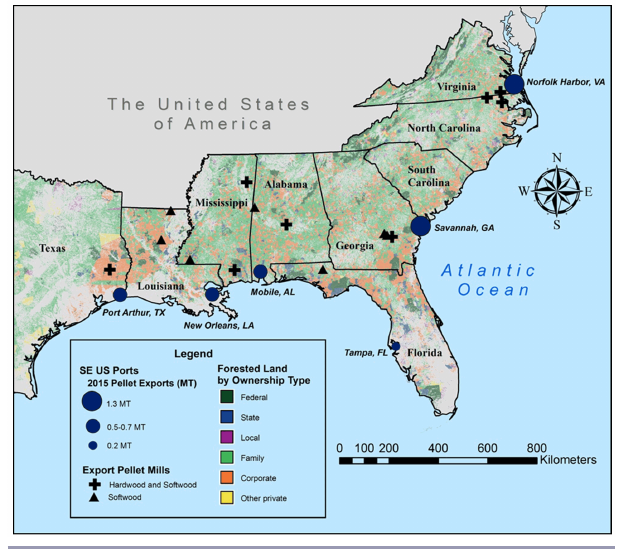
Fig. 3. Map of the southeastern U.S. sending system. Nearly all 2015 U.S. industrial wood pellet exports were shipped to Europe from six ports located on the coasts of Virginia (28%), Georgia (28%), Florida (14%), Alabama (13%), Texas (10%), and Louisiana (5%; USITC 2016). The wood pellets were delivered to these ports from 16 export pellet mills, which obtained their woody materials from forests and saw timber mills within a 120 km radius (Stewart 2015). The majority of southeastern U.S. forests are privately owned by families (Forest Service Research Data Archive ownership data